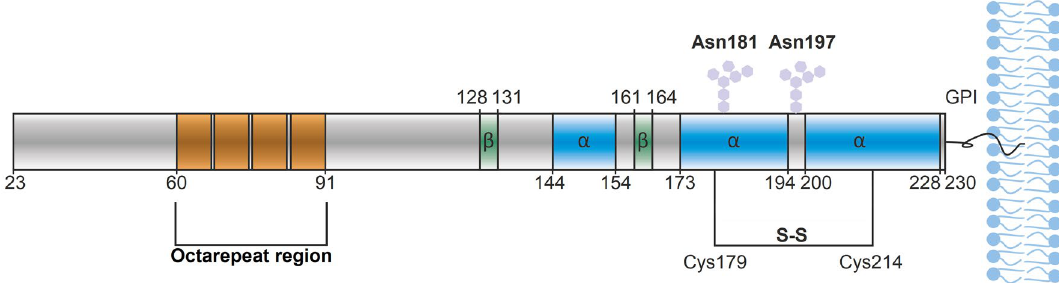
Figure 1. Schematic representation of the mature human PrP C protein. PrP C consists of an N-terminal intrinsically disordered domain and a C-terminal structured domain. The octarepeat (OR) region is marked in orange, α-helices are marked in blue, β-sheets are marked in green, hexagons represent the glycosylation sites, S–S is a disulfide bridge and GPI represents the glycosylphosphatidylinositol